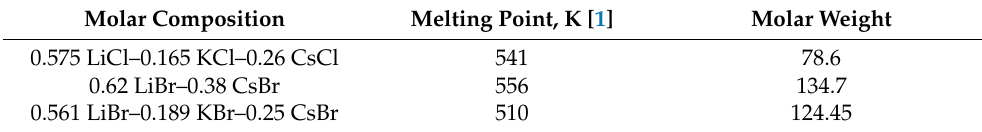
Table 1. Compositions and melting points.